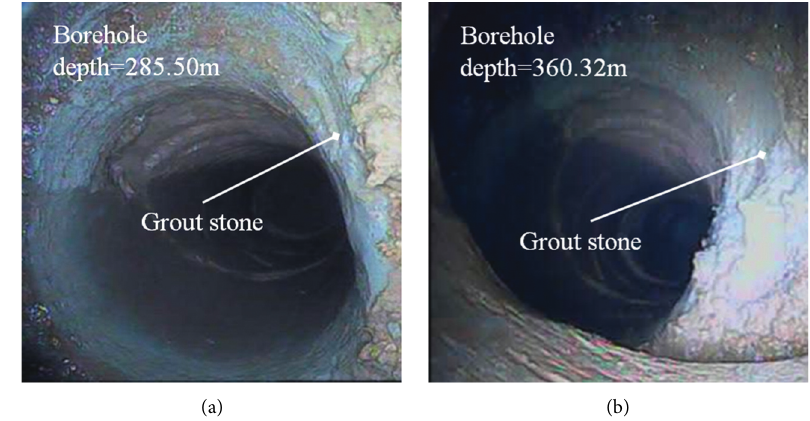
Figure 12: Grout stone in the checking borehole.